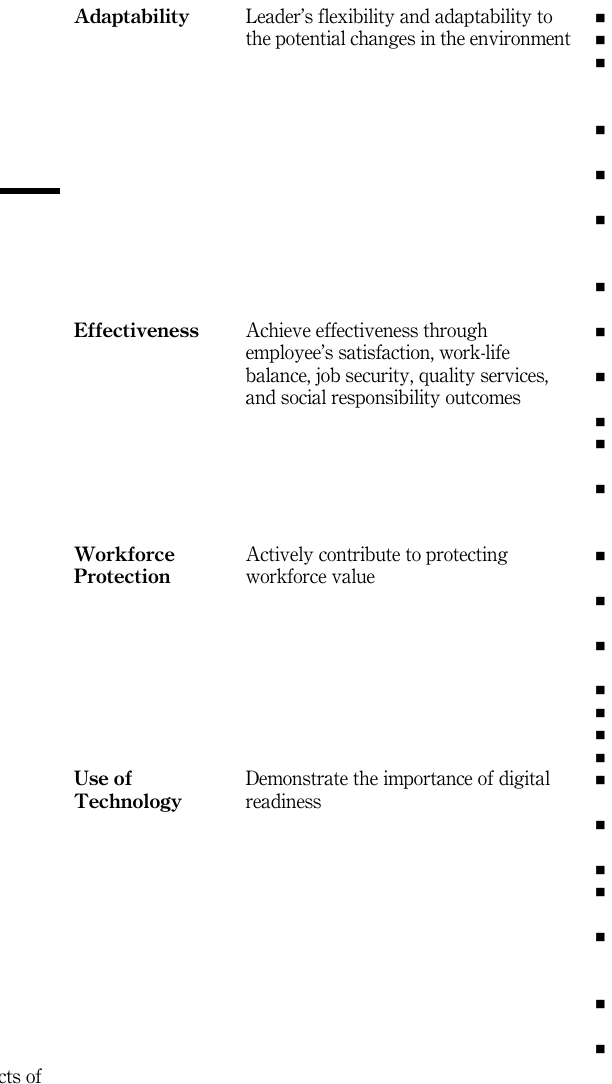
Table 2. Critical constructs of contingency